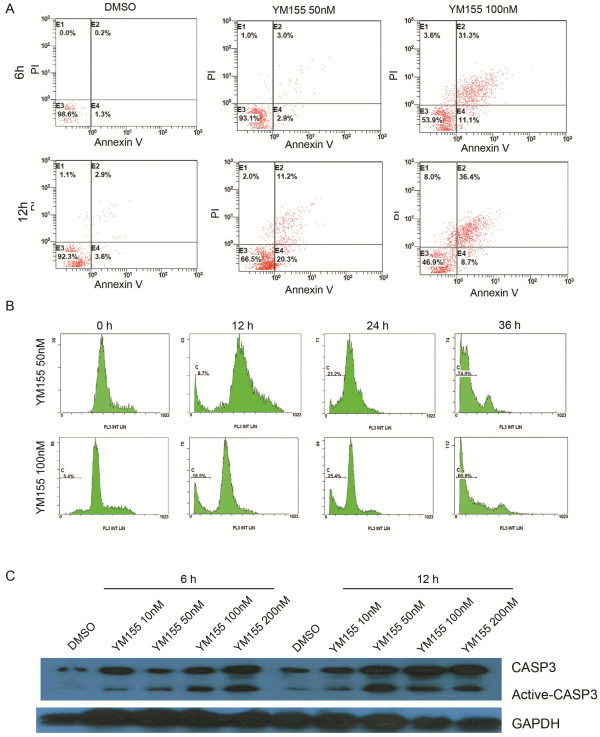
YM155 induced apoptosis in SK-NEP-1 cells. YM155 induced apoptosis, DNA fragmentation and activation of caspase 3 in SK-NEP-1 cells. (A) Annexin V analysis showed the cells treated with YM155 50nM and 100nM for 6 and 12 hours, much more cells showed apoptotic feature compared with control group. These analyses were repeated three times, and the apoptotic cells in 6 hours was YM155 50nM: 5.9% ±2.3%,YM155 100nM 42.4% ±8.9% compared to DMSO group: 1.5%±0.4%; apoptotic cells in 12 hours was YM155 50nM: 31.5% ±5.7%, YM155 100nM 45.1% ±11.3% compared to DMSO group 6.5% ±2.1%. (B) Cell cycle analysis the cells treated with YM155 after 12, 24 and 36 hours. As expected, DNA fragmentation was observed after 12 hours treatment and increased in a time dependent manner. These analyses were repeated three times, and the apoptotic cells in YM155 50nM group: 12 hours 8.7% ±1.4%, 24 hours 23.2% ±6.7%, 36 hours 74.0%±9.2%; apoptotic cells in YM155 100nM group: 12 hours 18.5% ±3.7% , 24 hours 25.4% ±9.2% , 36 hours 60.9% ±14.2%. (C) Western-blot analysis the activation of caspase 3 in cells treated with YM155. After 6 and 12 hours treatment with 10nM, 50nM, 100nM and 200nM YM155, cleaved caspase-3 was observed.